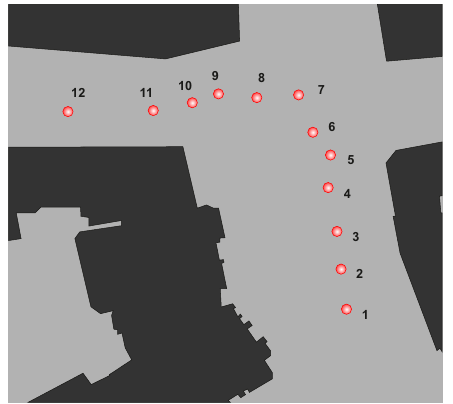
Figure 2. Map of the Hannover “Holzmarkt”: the position of buildings is visualized in dark gray and the scan positions for different scans S j are indicated with red spots. The scan IDs are adapted according to (Brenner et al., 2008).